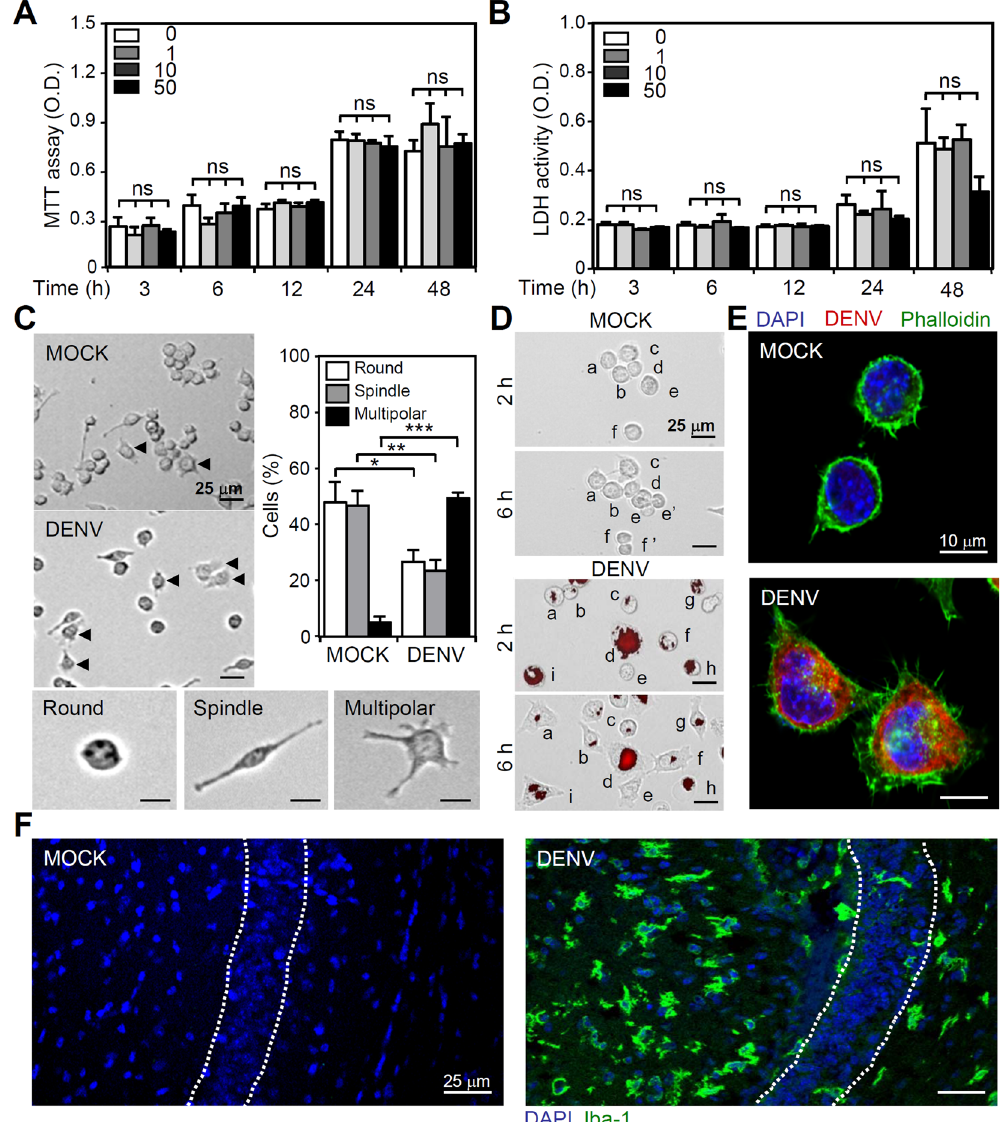
Figure 2. DENV infection causes minor effects on cell growth but considerably changes microglial cell morphology. ( A ) MTT and ( B ) LDH assays showed the cell viability and cytotoxicity, respectively, of BV2 cells inoculated with different MOIs of DENV 2 for the indicated different times. The quantitative data (optical density, O.D.) are shown as the means ± SD from three independent experiments. ns, not significant. The cells were inoculated with DENV 2 (MOI = 50) ( C ) without or ( D ) with Alexa-594 labeling ( red ). At 6 h post-infection, time-lapse microscopy showed changes in cell morphology characterized as round, spindle, and multipolar. The percentages of cells with morphological changes were determined and quantified as the means ± SD of three independent experiments. * p < 0.05, ** p < 0.01, and *** p < 0.001. ( E ) Confocal microscopy showed actin polymerization ( green ) after DENV infection as detected by viral E protein expression ( red ). ( F ) Representative confocal fluorescent immunostaining of Iba-1 ( green ) in DENV-infected brains. Dotted lines indicate the hippocampal region. For all images, representative data were selectively obtained from three individual experiments. DAPI staining indicated the nuclei ( blue